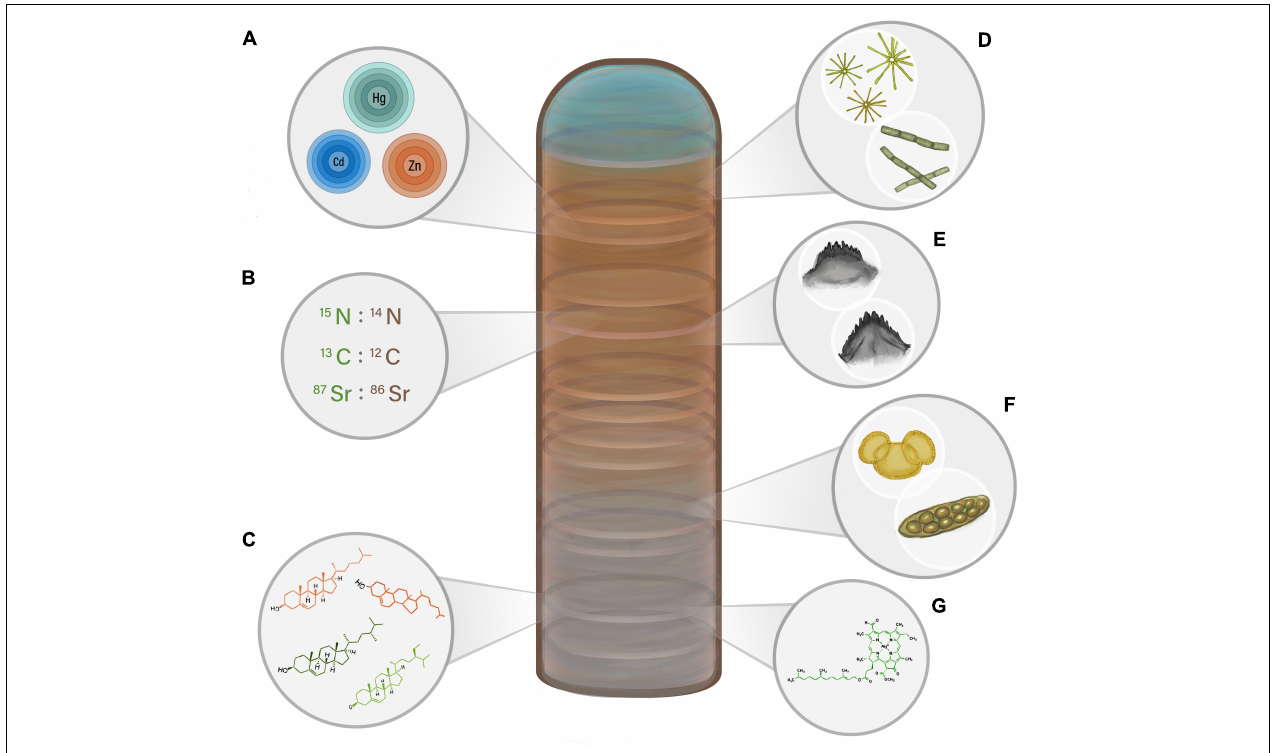
FIGURE 2 | A visual representation of the main paleolimnological proxies discussed in this review that can be used to reconstruct past biovector numbers. Increases and decreases in colony size, and thus the amount of biovector waste inputs, can result in changes in the relative abundance and prevalence of the proxies, including (A) bio-elements; (B) stable isotope ratios; (C) lipid biomolecules; (D) diatoms; (E) invertebrate sub-fossils; (F) terrestrial pollen and non-pollen palynomorphs; and (G)